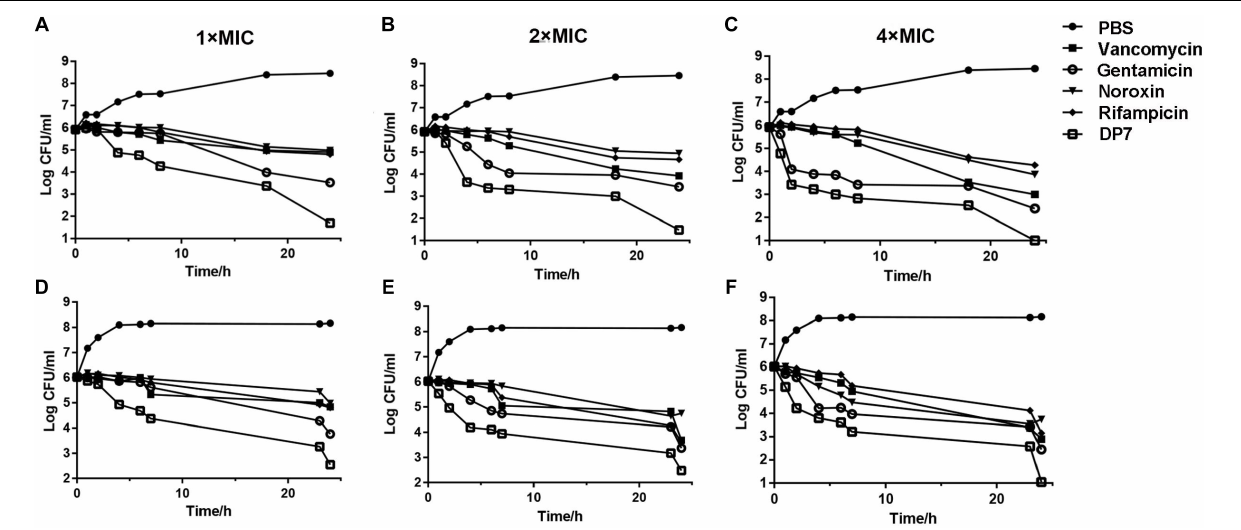
FIGURE 1 | In vitro time-killing curves of DP7 compared with some other general antibiotics. Time-killing kinetics of DP7 (open squares) (MIC use here is 16 mg/L), vancomycin (squares) (MIC use here is 0.25 mg/L), gentamicin (open circles) (MIC use here is 0.125 mg/L), noroxin (inverted triangles) (MIC use here is 1 mg/L), and rifampicin (diamonds) (MIC use here is 0.125 mg/L) with untreated bacteria as a growth control (closed circles) at (A) 1 × MIC, (B) 2 × MIC, and (C) 4 × MIC against S. aureus ATCC 25923 at 0, 1, 2, 4, 6, 8, 18, and 24 h. ( n = 3); at (D) 1 × MIC, (E) 2 × MIC, and (F) 4 × MIC against S. aureus ATCC 33591 at 0, 1, 2, 4, 6, 8, 18, and 24 h ( n = 3).